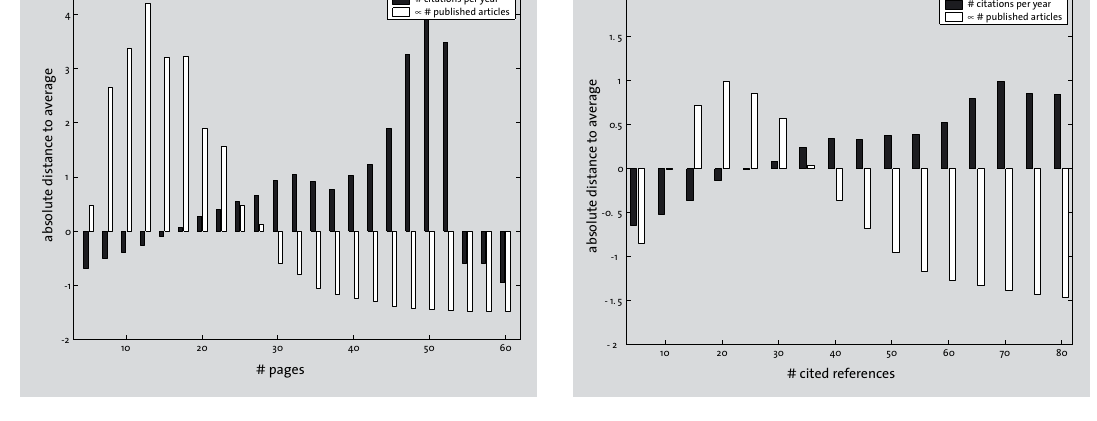
Fig. 2: Same representation as for Fig. 1 for the number of cited references rather than for the number of article pages. Most often, article cite 15-25 references, but the CPY of article significantly increas- es with the number of refer- ences. Notice, that the (mean) number of refer- ences is linear in the number of publication pages with a factor of proportionality close to 1.9 references per article page. The mean number of cited references for all scanned publications between 1995 - 2004 is